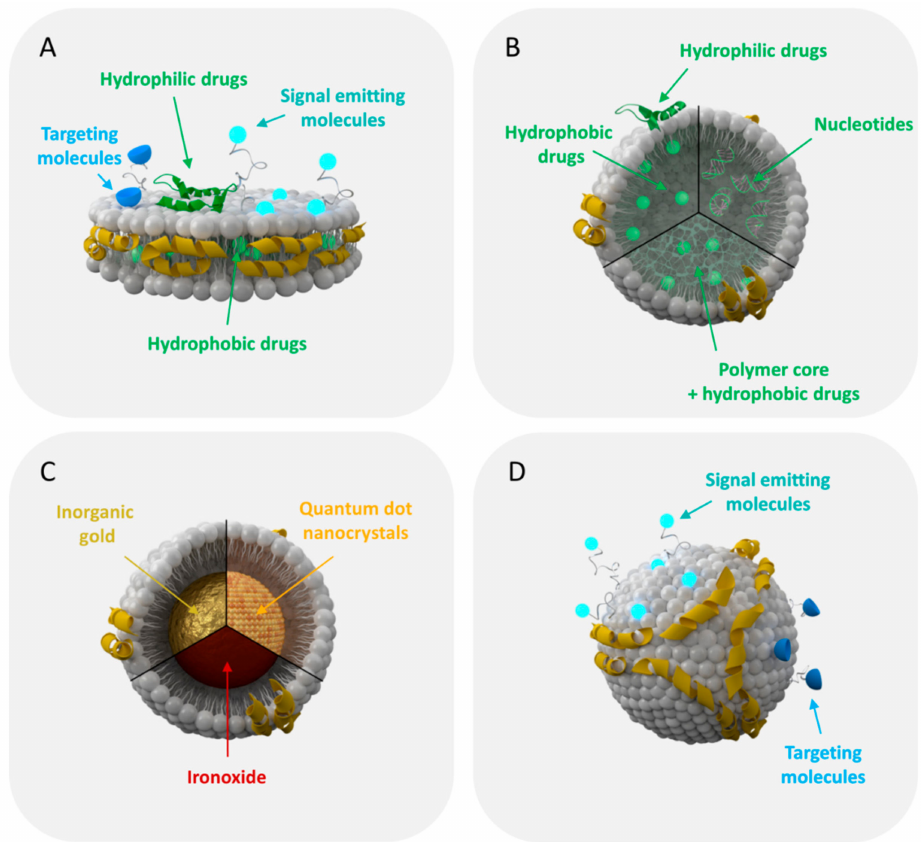
Figure 3. Schematic presentation of the rHDL nanoparticle platform currently explored for drug delivery and imaging. ( A ) apo-AI and phospholipid molecules self-assemble to form rHDL nanodiscs, which can be adapted as multifunctional nanocarrier for drug delivery or imaging. ( B ) Spherical rHDL particles can be loaded with hydrophilic / hydrophobic drugs or oligonucleotides to be used as nanotherapeutics. ( C ) rHDL can be built with an inorganic core of varying size for medical imaging and diagnosis. ( D ) The surface of rHDL can be modified with signal emitting dyes for optical, nuclear, or magnetic resonance imaging. Targeting ligands like antibodies or proteins can coupled to the surface of the particle to redirect rHDL to receptors / biomarkers other than their natural